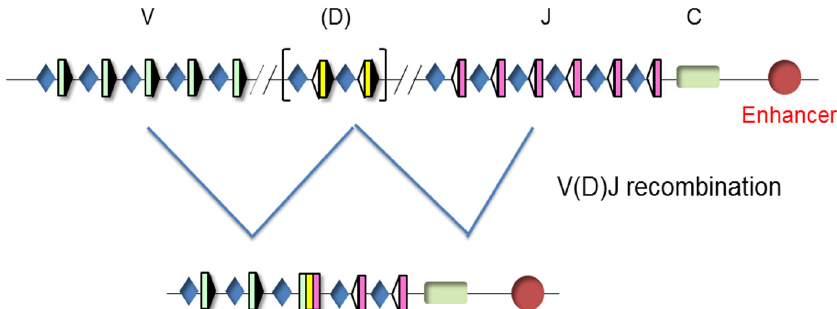
Figure 3. Unrearranged and rearranged T-cell receptor (TCR) gene structure. Variable (V), diversity (D), and joining (J) gene segments are indicated by green, yellow, and pink rectangles, respectively. Recombination signal sequences (RSSs) are represented by triangles adjacent to the V, D, and J gene segments (black triangles indicate RSSs with a 23 bp spacer and white triangles indicate RSSs with a 12 bp spacer). The constant (C) region is represented as a green rectangle. The enhancer is represented as a red circle and the promoters associated with the V, D, and J gene segments are represented by blue diamonds. V(D)J rearrangements are represented by blue